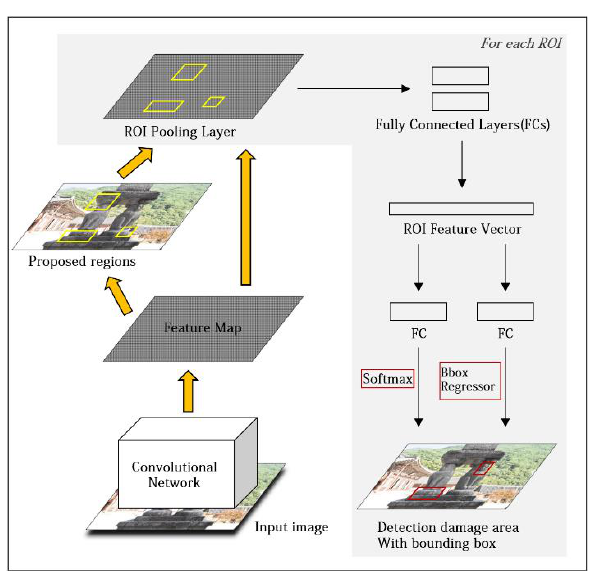
Figure 5. Process a faster R-CNN for damage detection.